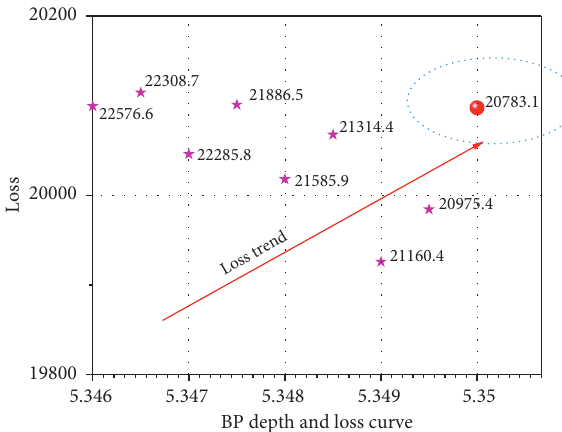
Figure 5: BP depth neural network model loss